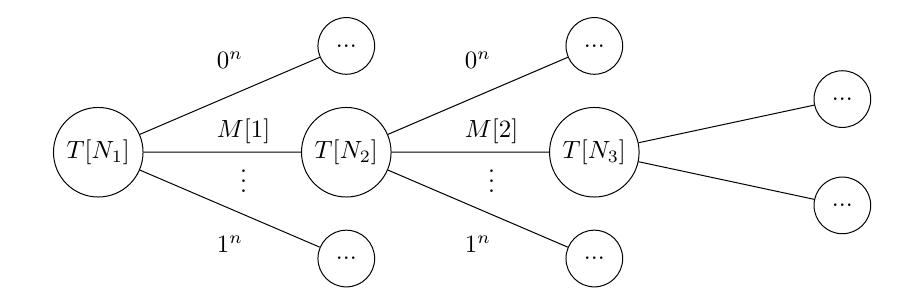
Figure 1: Tree representation of an online permutation and computation of C = π T ( M